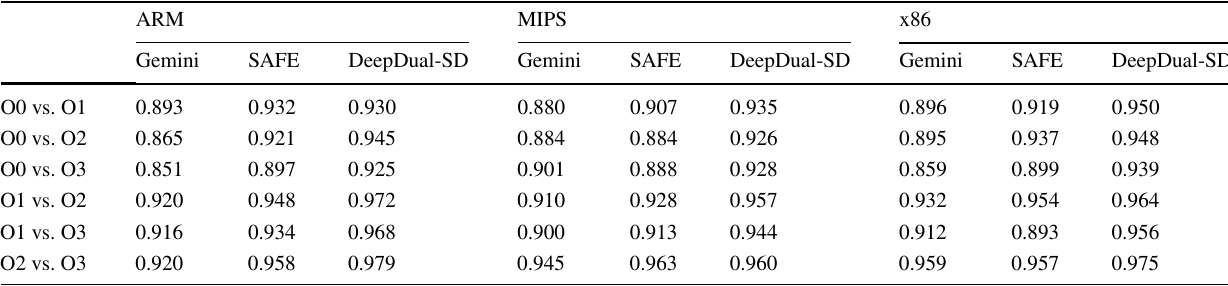
Table 3 Comparing percentage of matching functions AUC by different methods (DeepDual-SD, Gemini and SAFE) in cross-optimization-level settings. O0, O1, O2, O3 are situations in which compilation using four different optimization levels